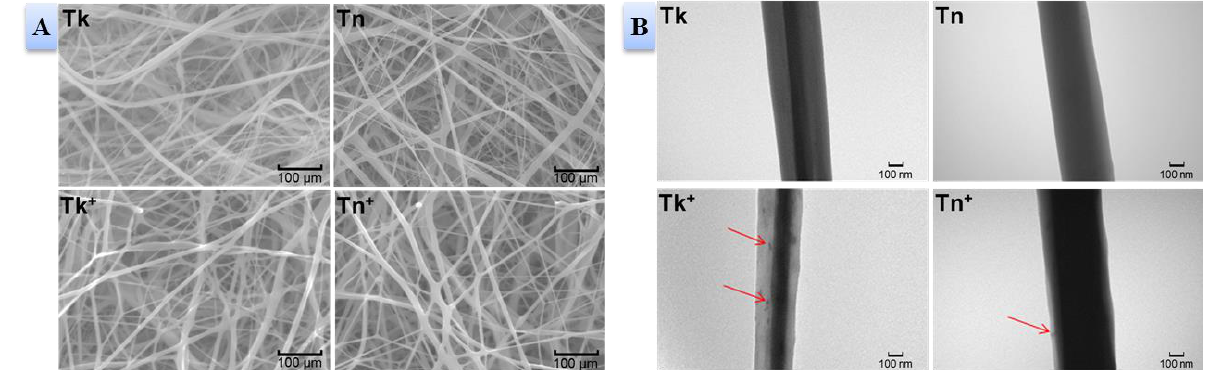
Figure 1. The scanning electron microscopy (SEM) ( A , bar = 100 µ m) and transmission electron microcopy (TEM) ( B , bar = 100 nm) images of Tk, Tn, Tk + , and Tn + core-sheath nanofiber membranes (CSNFMs). The red arrows in ( B ) indicate Ag NPs in the sheath.